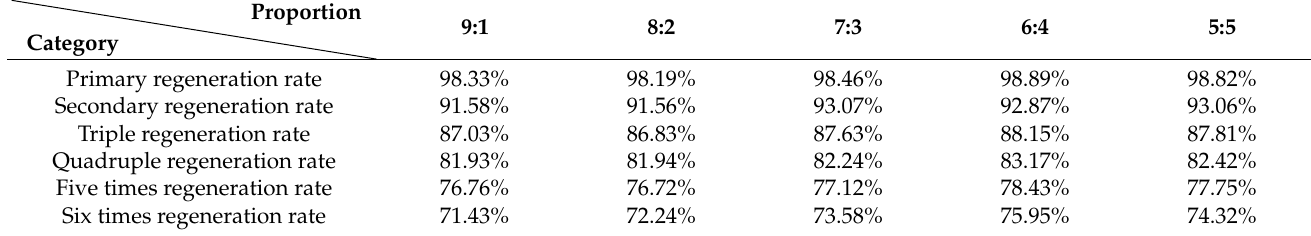
Table 8. Regeneration rate of AEP-DPA composite